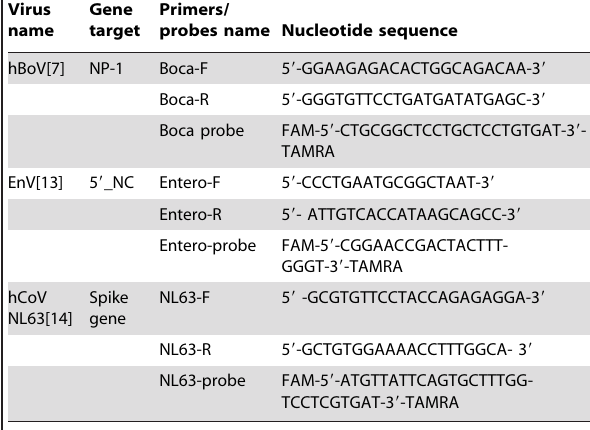
Table 1. Primers and probes used in monoplex real-time RT-PCRs to detect HBoV, enterovirus and